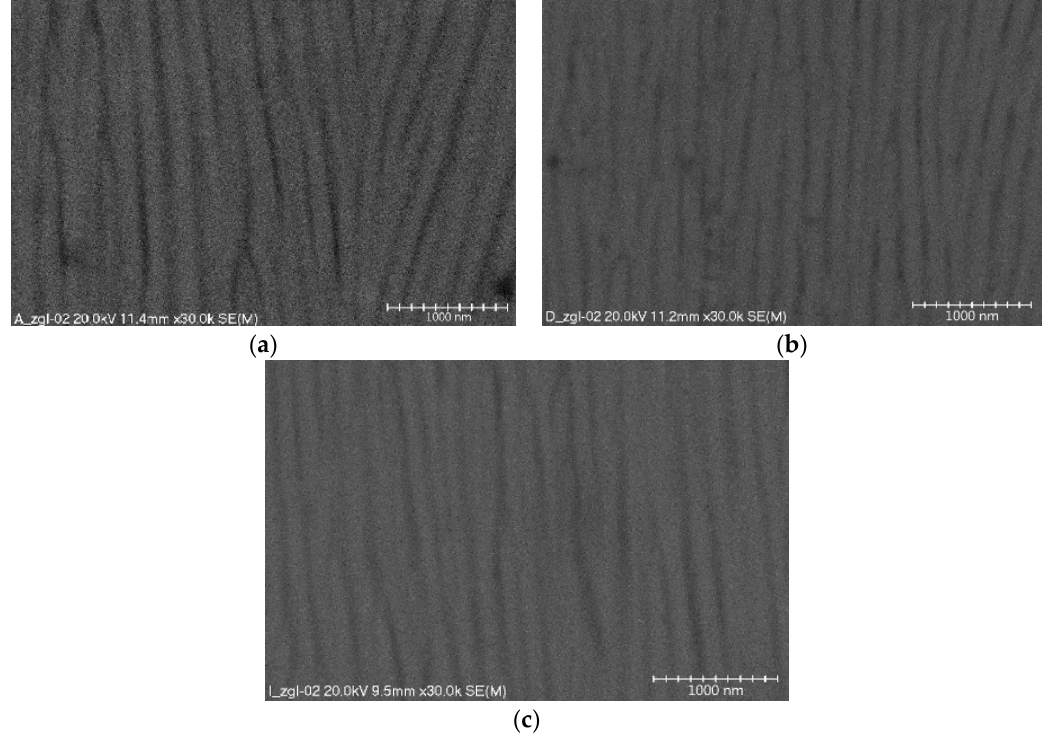
Figure 1. Cross-sectional image of columnar-fibrous structure of oxide layers produced at current density of 2 A/dm 2 in electrolyte at temperatures of: ( a ) 293; ( b ) 298; ( c ) 303 K.